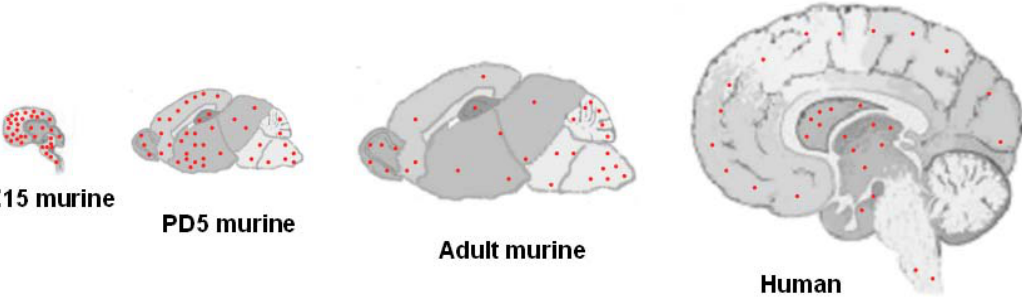
FIGURE 1. Spatial and temporal distribution of DYRK1A during life span. DYRK1A is abundant in early developmental stages in neurons and has an expression pattern that appears in two waves in vertebrate embryos. The first wave is a transient expression in neural progenitor cells of early embryos[12]. The second wave occurs during late embryonic development. High levels of expression are still detected in early postnatal life that decrease until adulthood. In the adult, DYRK1A immunostaining is restricted to specific brain areas. It is strong in the olfactory bulb, the cerebellar cortex and functionally related structures, the spinal cord, and most of the motor nuclei of the midbrain and brain stem. These data agree with a possible implication of this kinase in the physiology of olfaction and motor